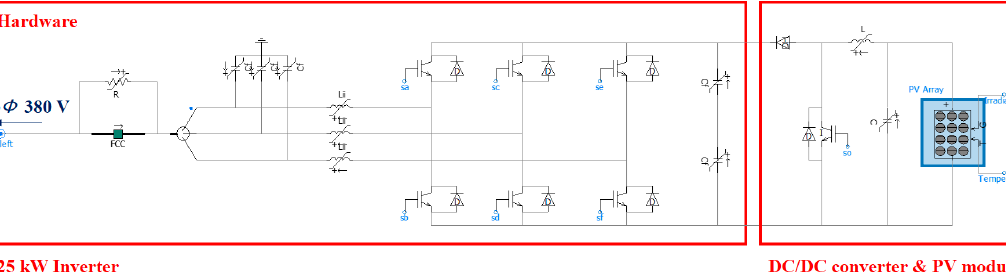
Figure 10. Simulation model of PV.